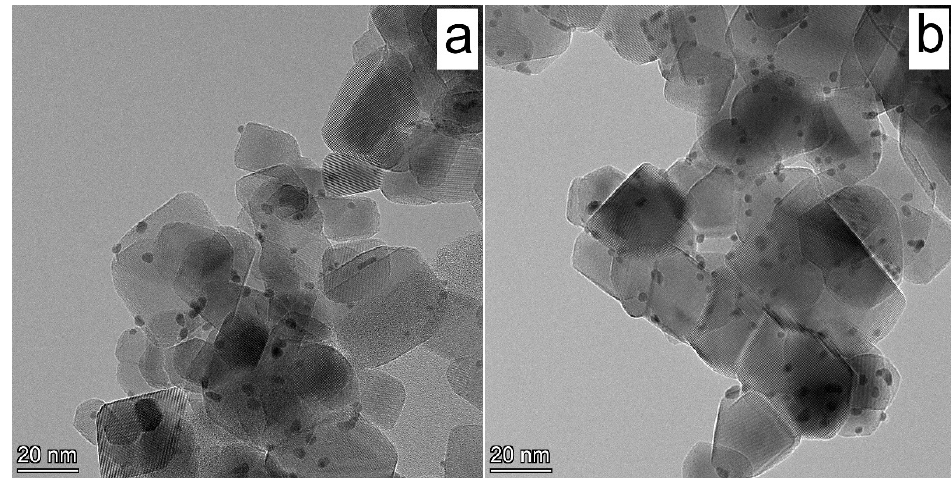
Figure 4. HR TEM micrographs of ( a ) fresh Pt/TiO 2 and ( b ) Pt/TiO 2 700 photocatalysts.